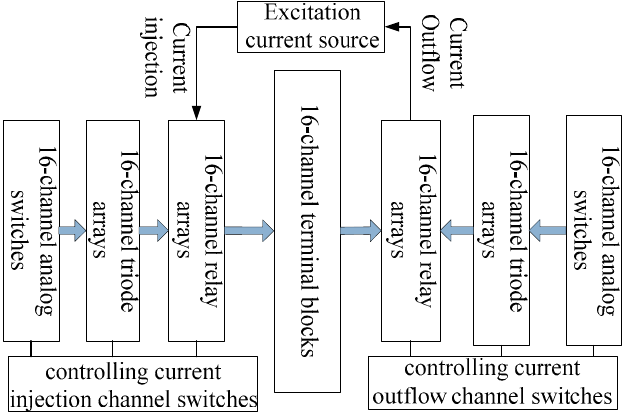
Figure 5. Channel switch module.